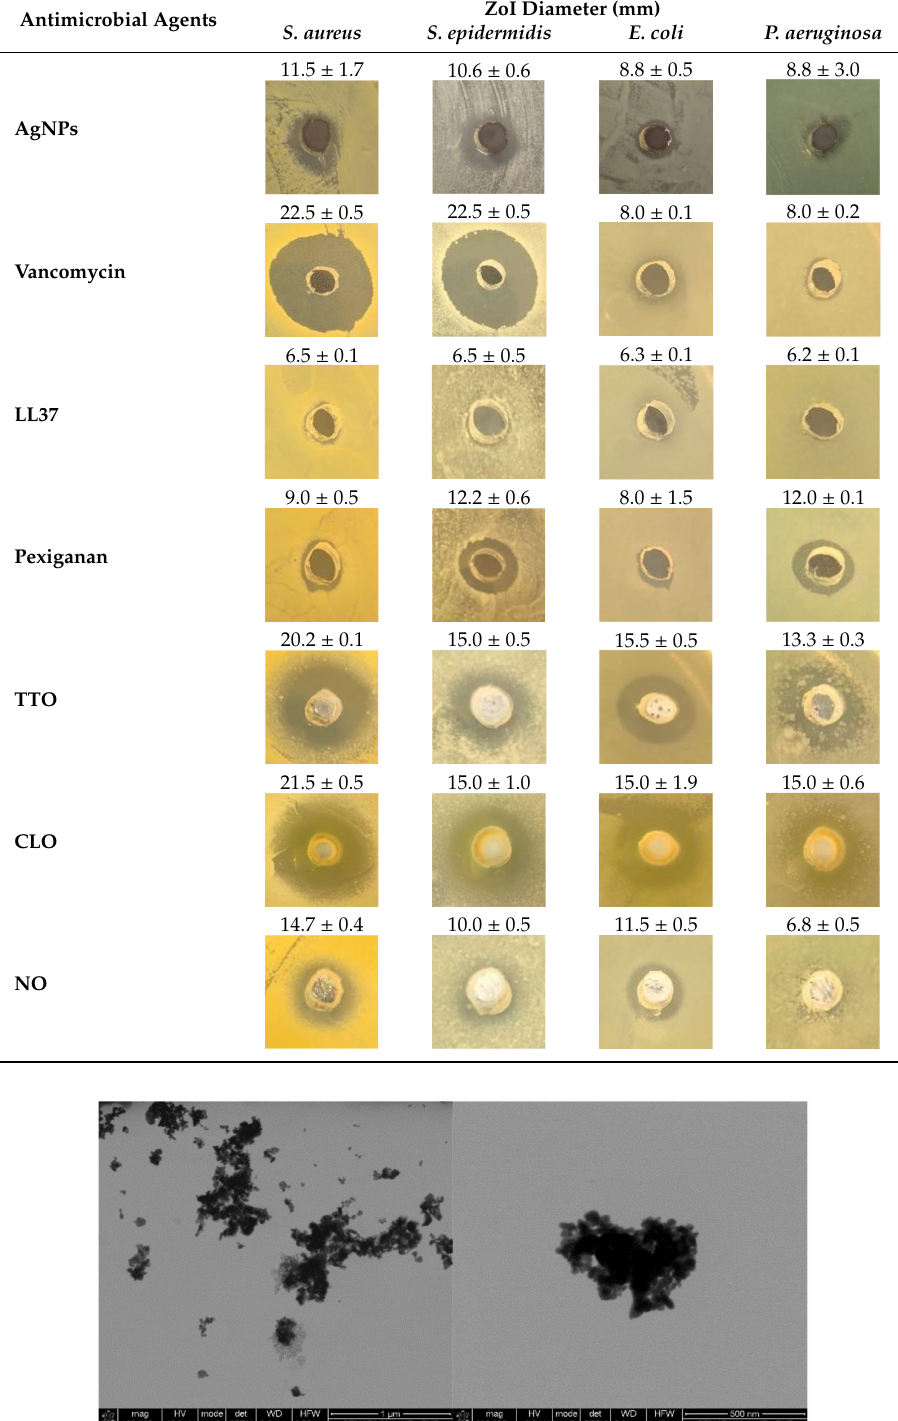
Figure 1. Silver nanoparticles (AgNPs) colloidal dispersion scanning transmission electron microscopy (STEM) micrographs at magnifications of × 100,000 and × 200,000 with evidence of formation of NPs